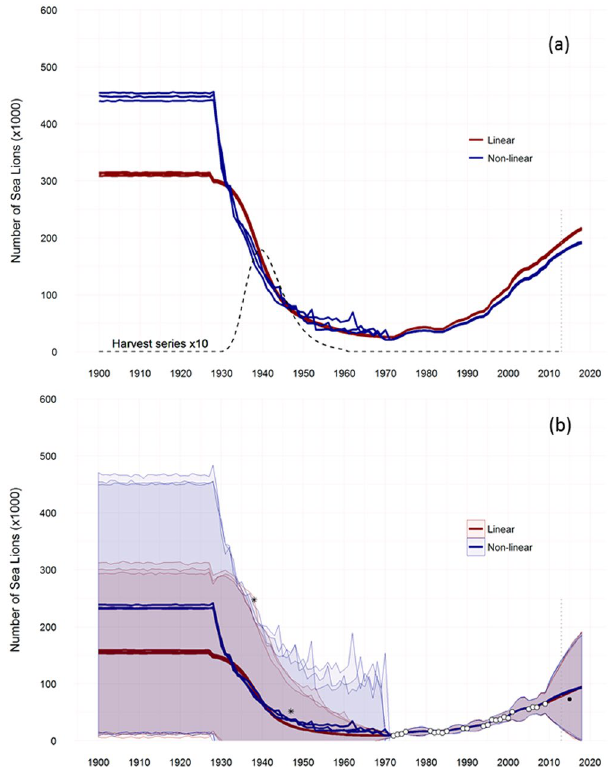
Figure 3. Abundance trajectories for all proposed models. ( a ) Posterior distribution of mean population abundances ( N t ) and harvest time-series (dashed line). ( b ) Predicted posterior mean ( ± SD) of observable states ( I t ) compared to the observed survey data (white dots). Asterisks represent the first two coarse estimates of population abundance of sea lions in Argentina 19, 20, 69 . Black dot corresponds to survey data for 2015. This data point was not included in the model fitting